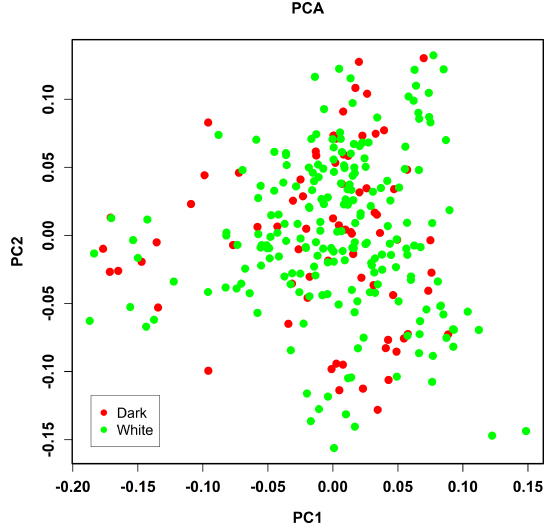
Figure 2. Population structure identified by the principal compo- nent analysis (PCA). Dark and white represent the face color of